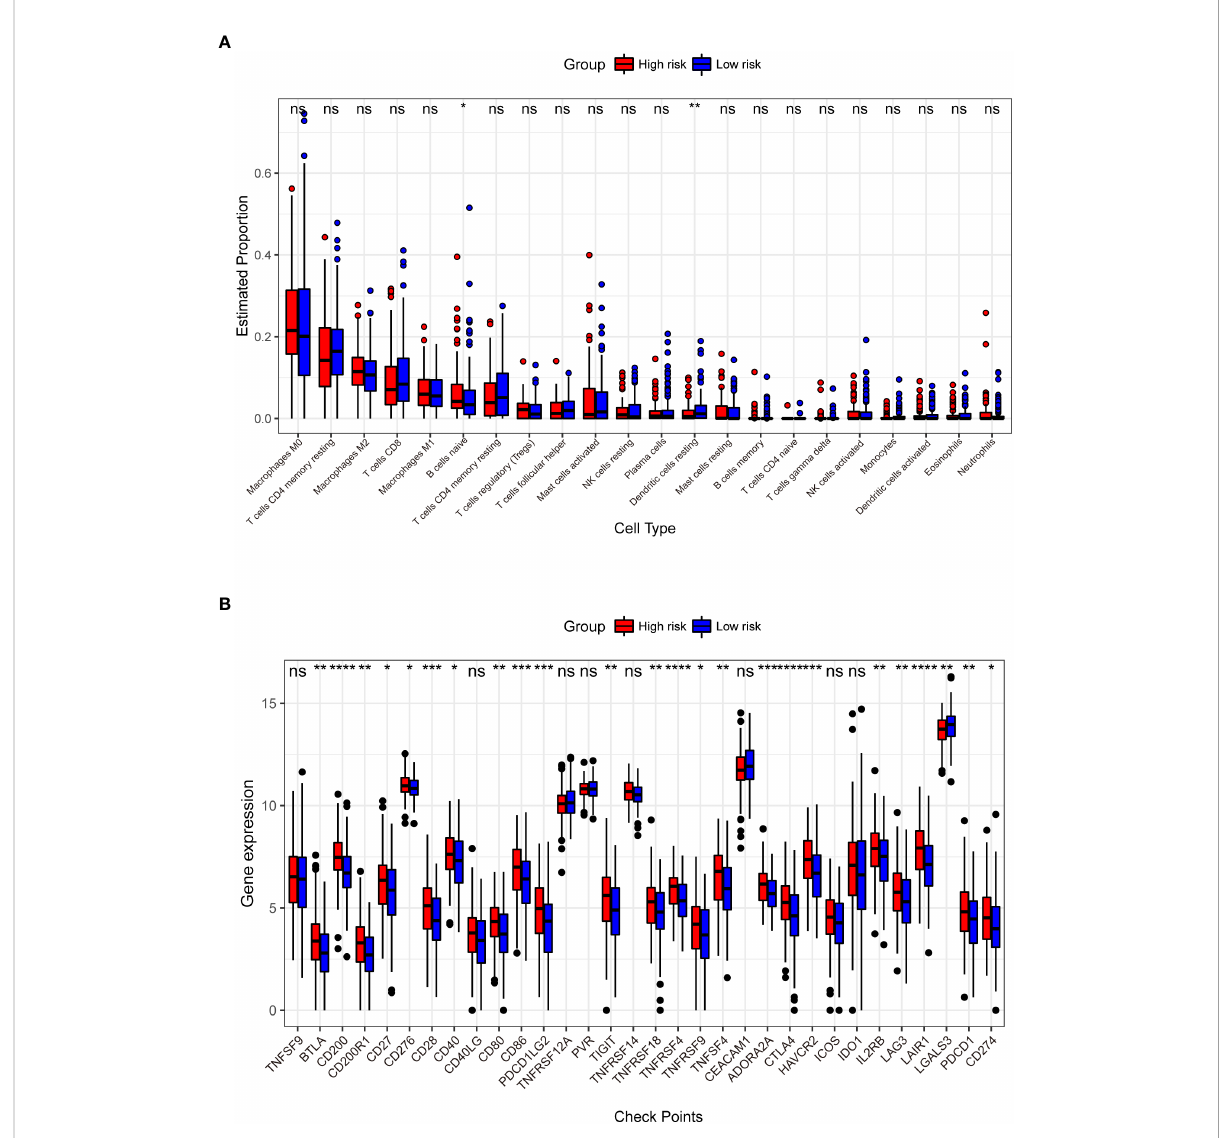
FIGURE 7 Comparison of the abundance of in fi ltrating immune cells between high- and low-risk groups (A) . The horizontal coordinate is in fi ltrating immune cells and the vertical coordinate is the estimated proportion. Differences in the expression of 32 immune checkpoints between the high- and low-risk groups (B) . The horizontal axis has the 32 immune checkpoints, and the vertical axis indicates the level of expression for each checkpoint. * p< 0.05, ** p< 0.01, *** p< 0.001, **** p< 0.0001, ns: not signi fi